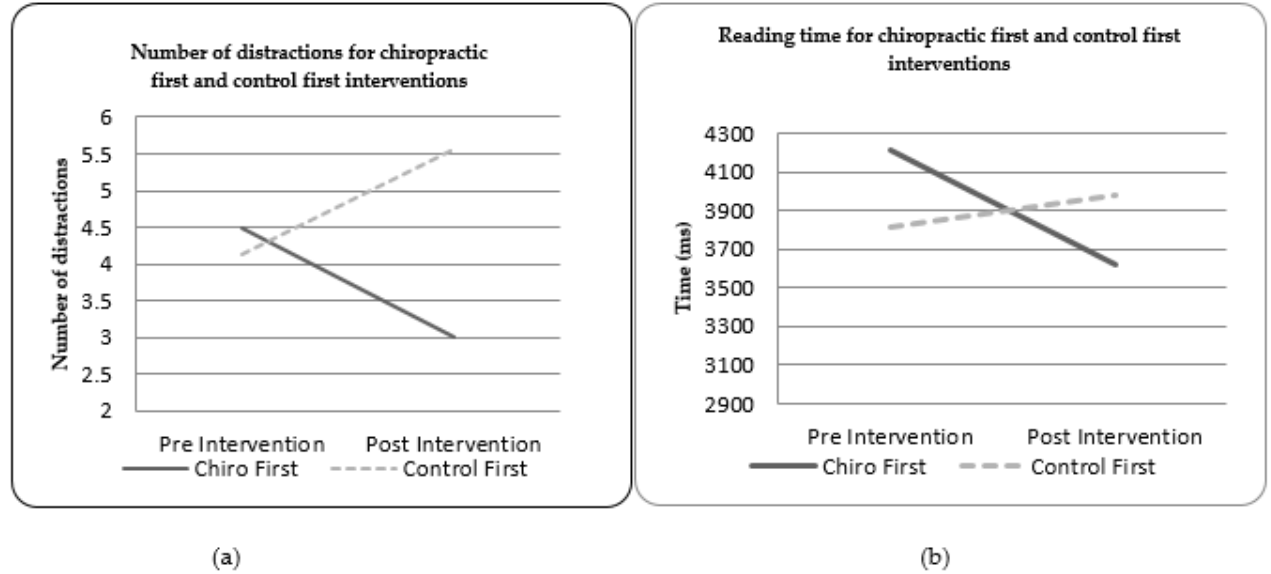
Figure 1. ( a ) Number of target distractions for the chiropractic first and control first interventions; ( b ) reading time for the chiropractic first and control first interventions.